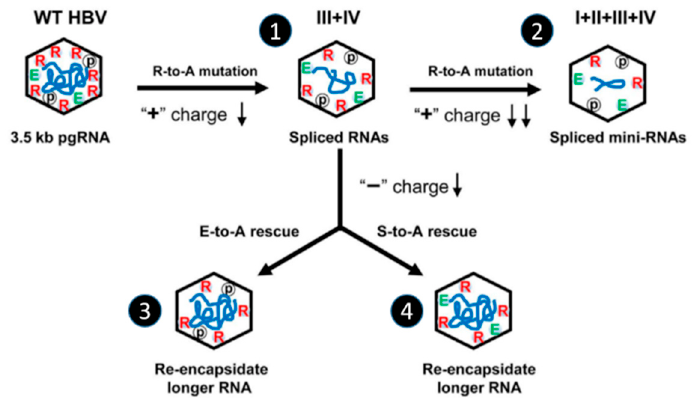
Figure 9. A subtle charge balance is required for RNA packaging. ARDs were mutated (R substituted for A) to reduce the positive charges and the status of packaged RNA is schematically shown by the blue line (pgRNA, 2.2-kb spliced RNA, 1.5 spliced mini-RNA). III + IV corresponds to HBc proteins where R165, 166, 173 and 174 of the third and the fourth ARDs were substituted for A. I + II + III + IV corresponds to HBc protein where R151, 153, 157, 158, 165, 166, 173 and 174 of all ARDs were substituted for A. The lower amount of positive charge of III + IV can be rescued by E–A or S–A substitution. This result suggests that the relative ratio of positive to negative charge appears more important than the quantity of either positive or negative charges for RNA packaging. Extracted and modified from Figure 7 of [53] and published under a CC BY 4.0 license.